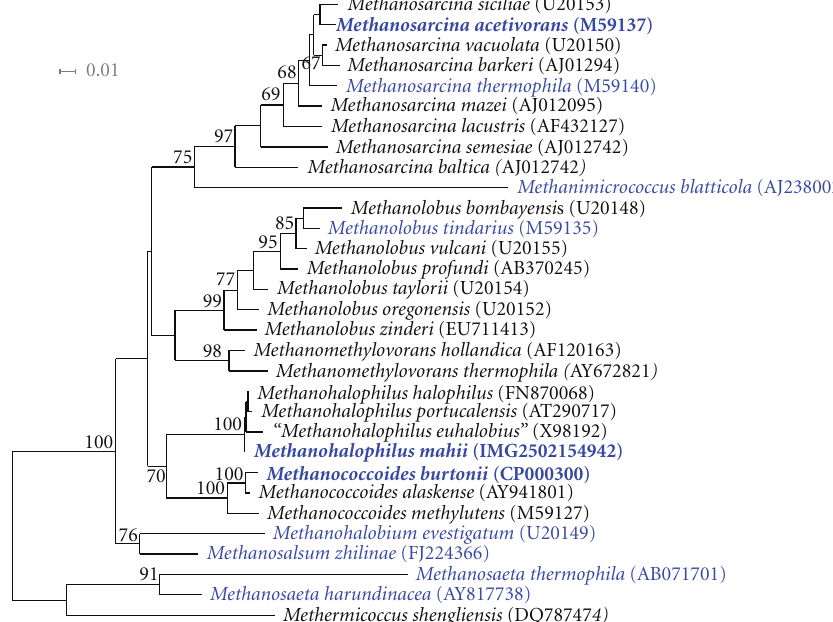
Figure 2: 16S rRNA-based phylogenetic tree showing the position of Mhp. mahii relative to the other type strains within the order Methanosarcinales . The tree was inferred from 1341 aligned characters [25, 32] of the 16S rRNA gene sequence under the maximum likelihood criterion [26] and rooted with representatives of the Methanocellaceae . The branches are scaled in terms of the expected number of substitutions per site. Numbers above branches are support values from bootstrap replicates [28] if larger than 60%. Lineages with type strain-genome sequencing projects registered in GOLD [10] are shown in blue, published genomes in bold.